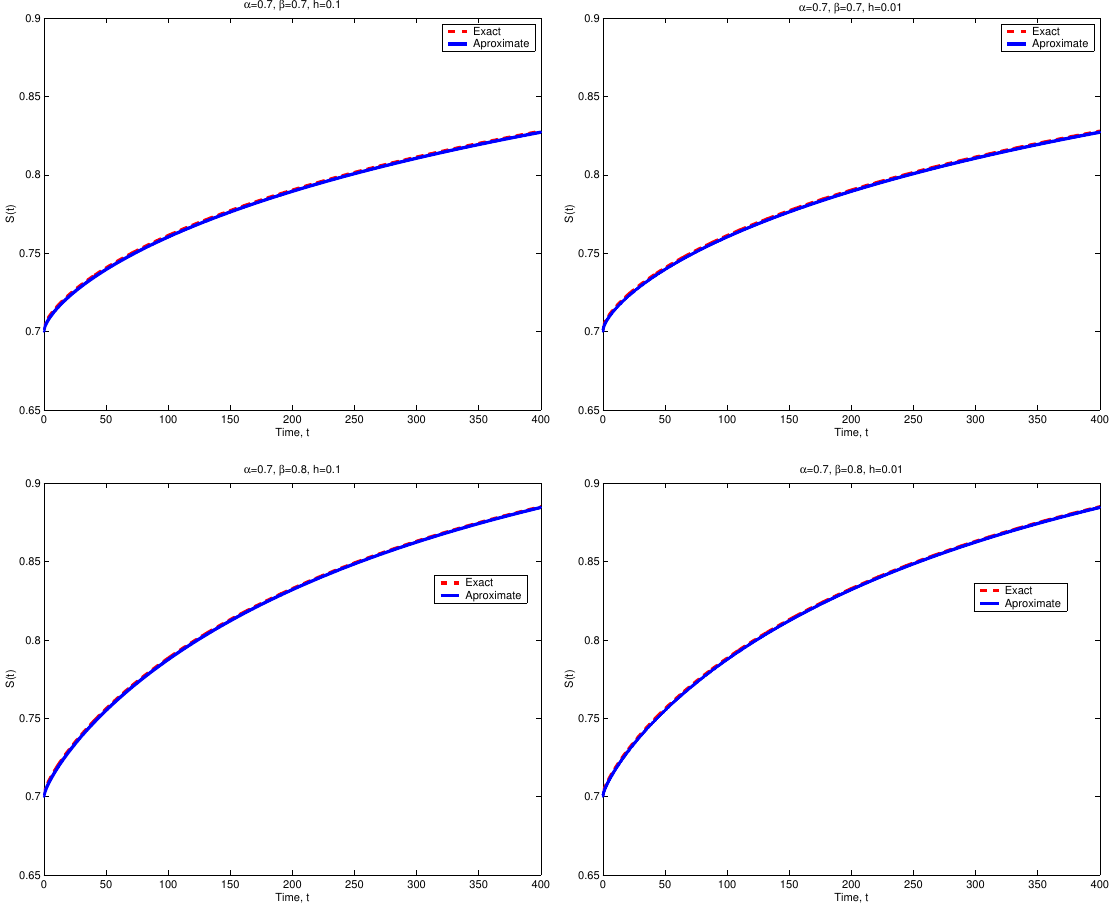
Figure 1. The exact and numerical solutions of (35) for different values of α , β , and h . In the presence of disease, System (31) cannot be solved analytically. Based on our numerical method, we approximate the solution of (31). Therefore, we chose κ = 0.4, ε = 0.085, r = 0.095, and β = 0.8. By computation, we have R 0 = 3.4085 > 1. In this case, the solution of (31) converges to the endemic equilibrium Q ∗ ( 0.2934, 0.0744, 0.0602 ) , which biologically means that the disease persists in the population. Figure 2 illustrates this observation for different values of α